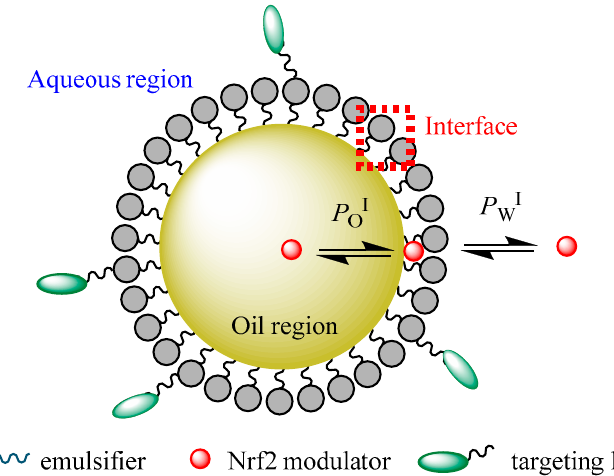
Figure 4. A schematic representation of a functionalized O/W nanoemulsion and distribution of a potential NRF2 modulator between their different regions (aqueous, interfacial, and oil regions). P WI and P OI stand for the partition constants between aqueous–interfacial and oil–interfacial regions, respectively.